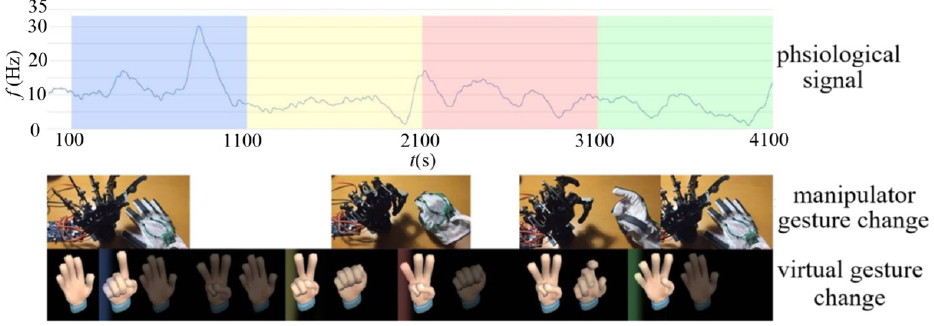
Figure 13. Gesture changes of subject 3 driven by emotion.